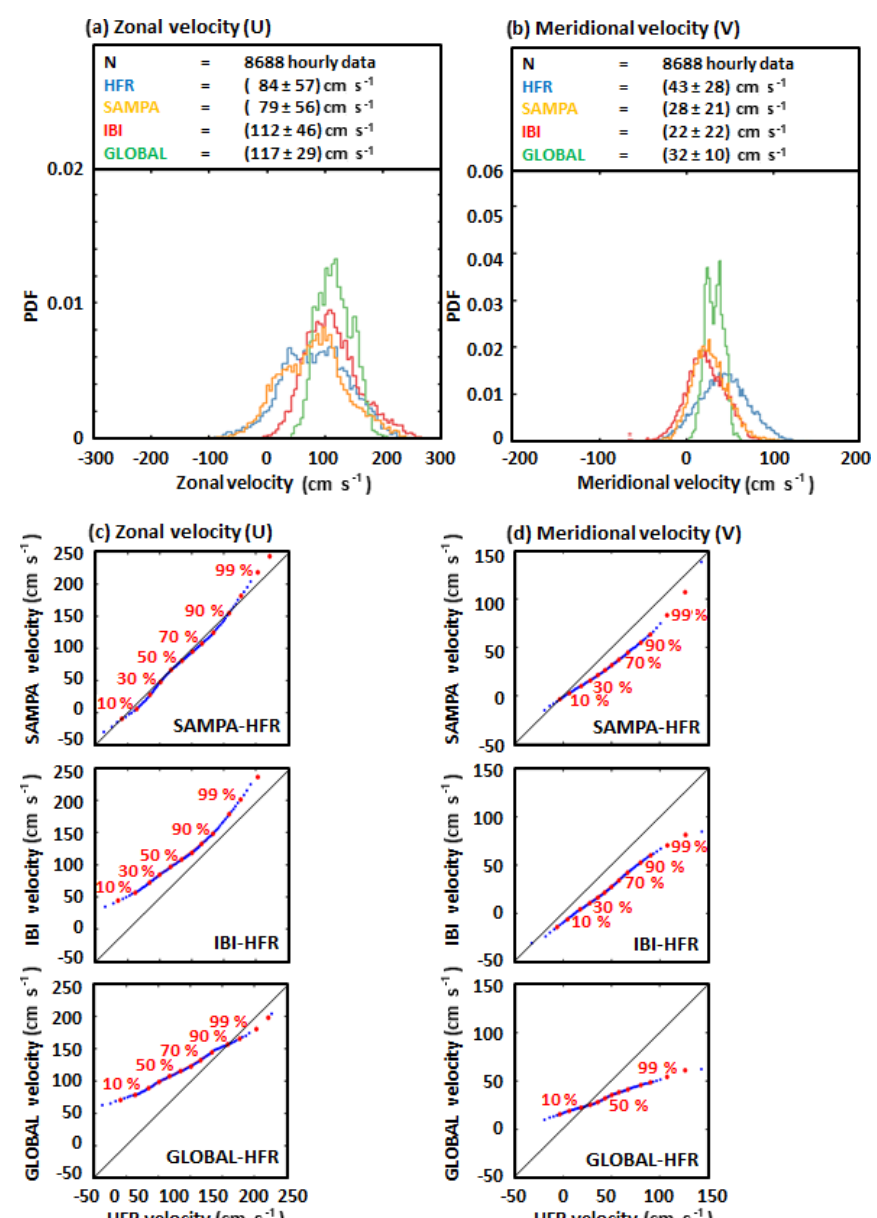
Figure 9. Annual (2017) histogram of hourly (a) zonal current velocities and (b) meridional current velocities, as provided by HFR, SAMPA, IBI, and GLOBAL. Mean and standard deviation values are gathered in black boxes. Quantile–quantile plots of hourly (c) zonal current ve- locities and (d) meridional current velocities, as derived from the observation–model comparison. The 10%–99% quantiles were established (red filled